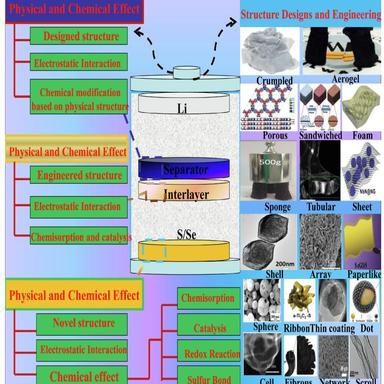
The detailed schematic diagram of rational structure designs and engineering including the mechanism basedonthephysicalandchemical effectof2DmaterialsofLi-S/Sebatteries.